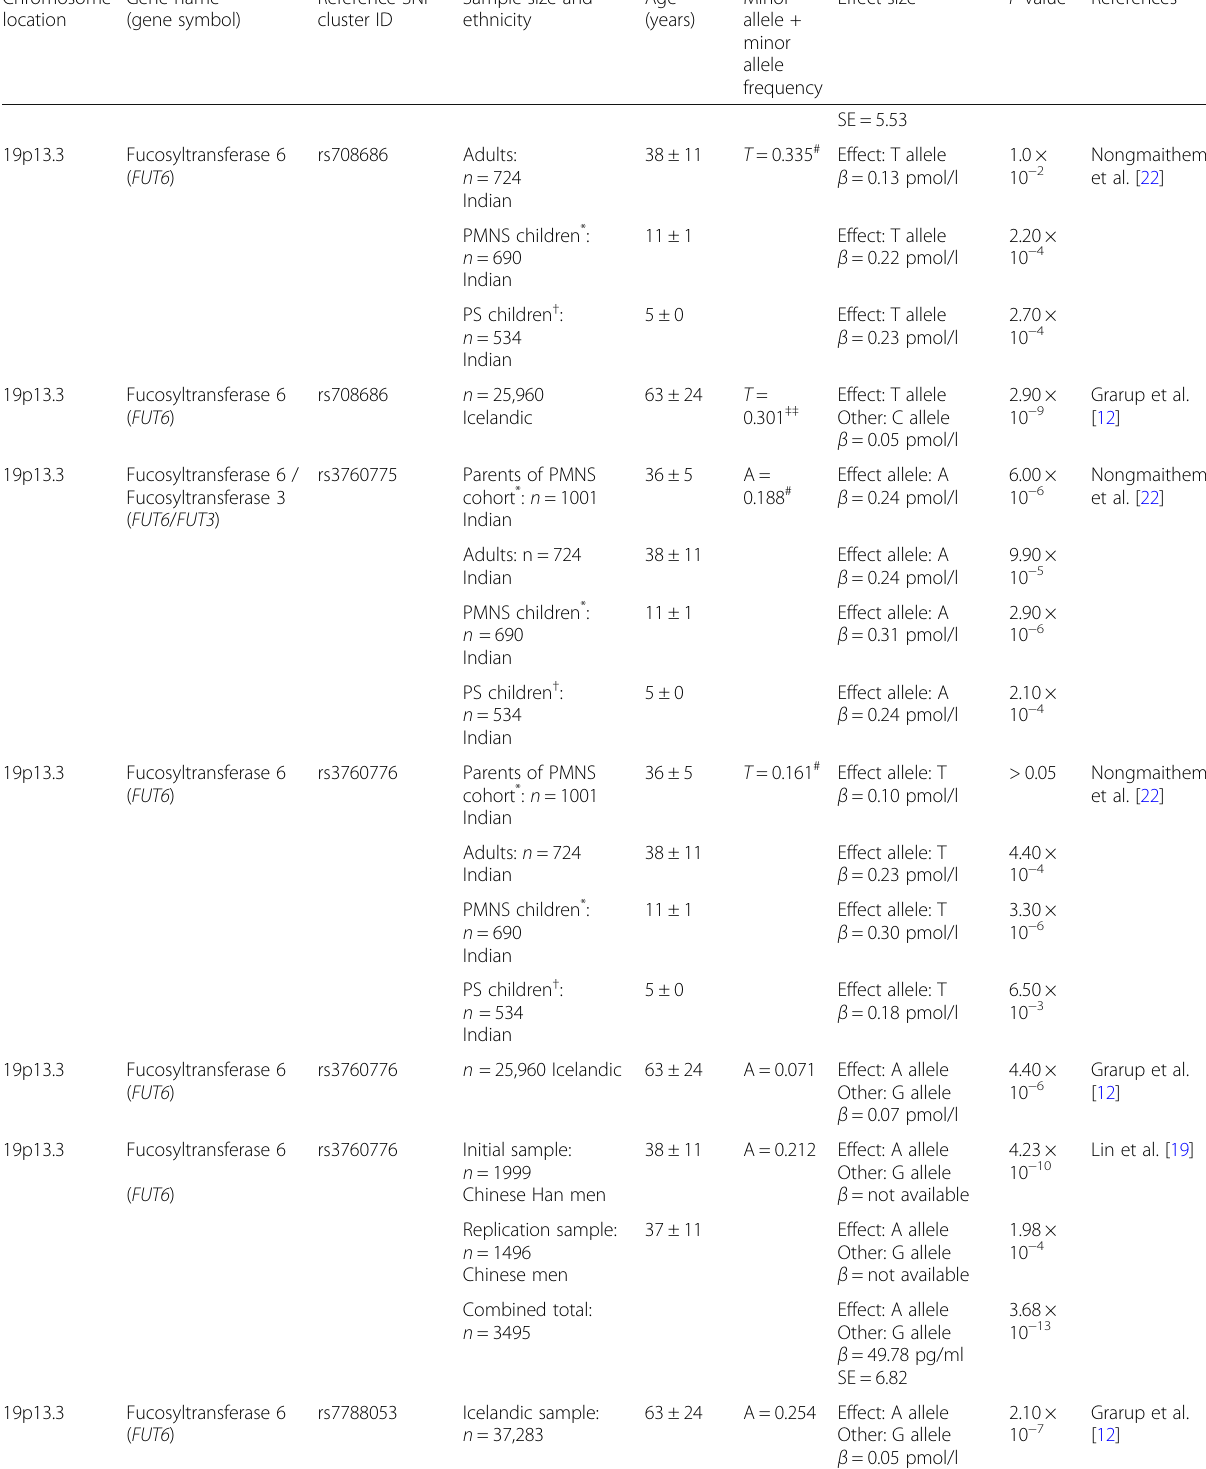
Table 1 Genome-wide association studies showing the association of SNPs with vitamin B12 concentrations. Genome-wide association studies testing the association between SNPs and vitamin B12 concentrations. The chromosome location, gene name, reference SNP cluster ID, sample size and ethnicity, mean age, observed frequency of the minor allele in the population, effect size and P value are shown in the table. The order of SNPs reflects the order of the chromosome location